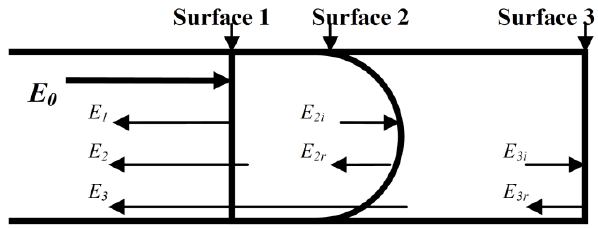
Figure 1. Schematic of the fiber-optic three-beam interferometric